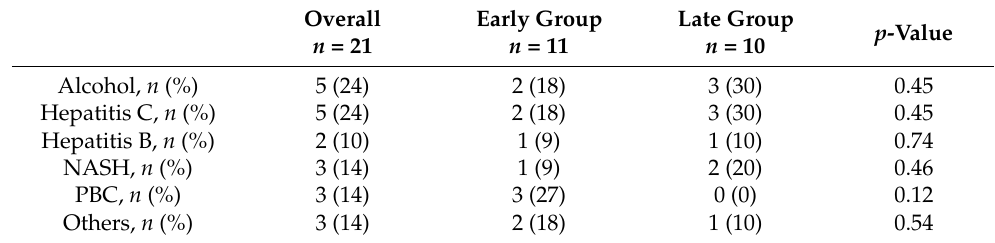
Table 6. Factors associated with early bleeding in the follow-up group: background